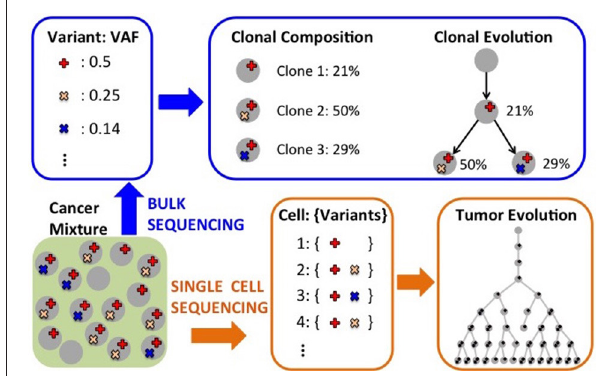
FIGURE 4 | Computational analyses to characterize intra-tumor heterogeneity. Starting from measurements (e.g.,VAFs) obtained from bulk sequencing of one or more tumor samples, one can infer the clonal composition of the sample and also the evolutionary relationships among clones. Single-cell sequencing can be use to infer the evolutionary relationships among the individual cells for which mutations have been